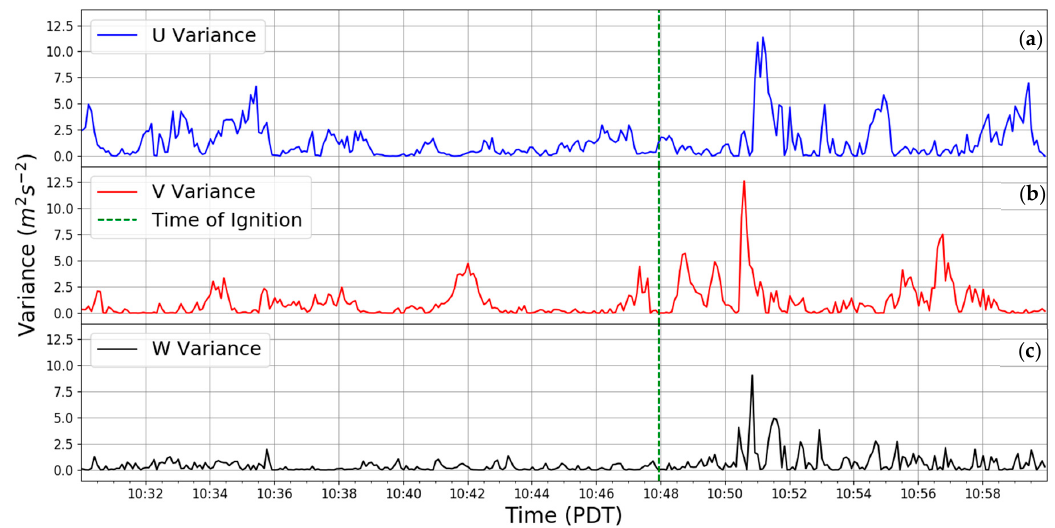
Figure 12. Time series of 10-s averaged velocity variances of ( a ) u, ( b ) v , and ( c ) w . The vertical dashed line indicates the time of ignition.